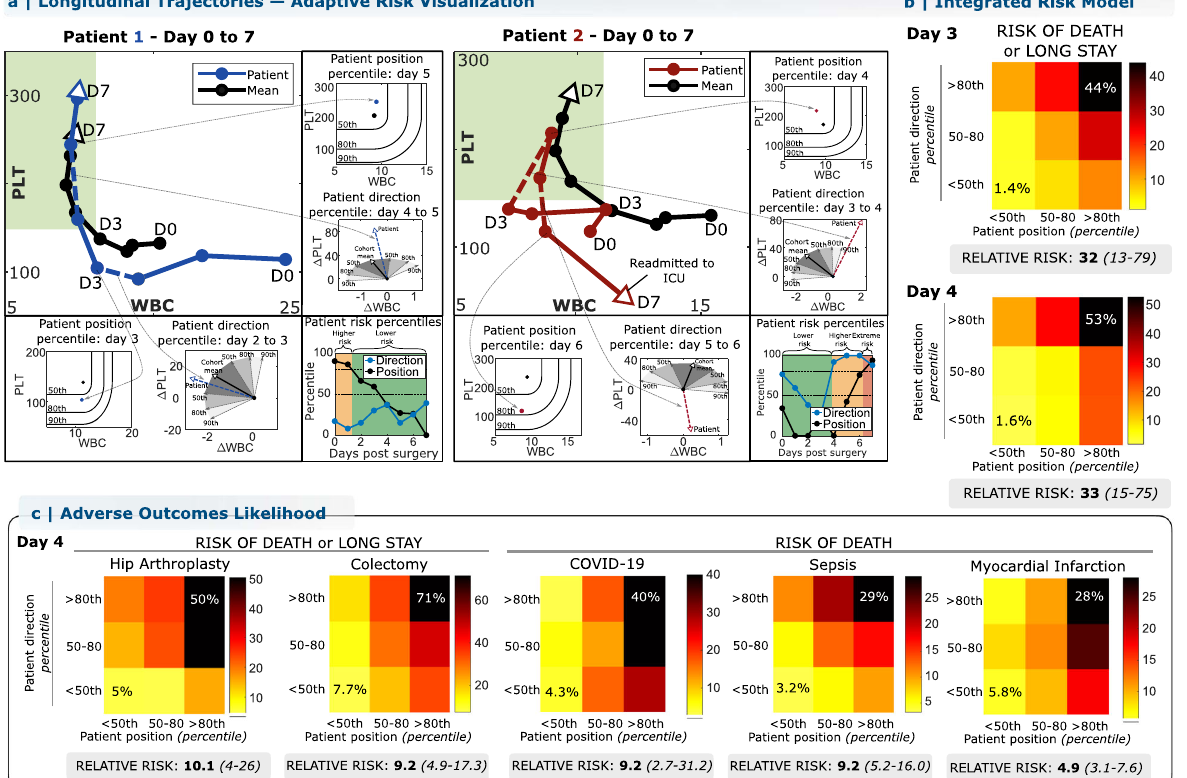
Fig.4|TheconservedWBC-PLTtrajectoryshapeprovidesagenericbenchmark for personalized patient risk assessment. WBC-PLT position and direction pro- videanintegratedtrajectory-basedriskmetric.Twopatientexamplesareprovided, one involving recovery of an initially high-risk patient ( a , Patient 1), and the other